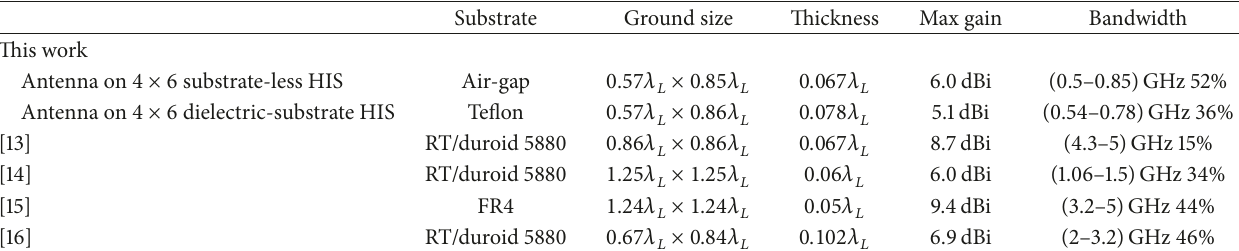
Table 2: Performance summary and comparison of HIS